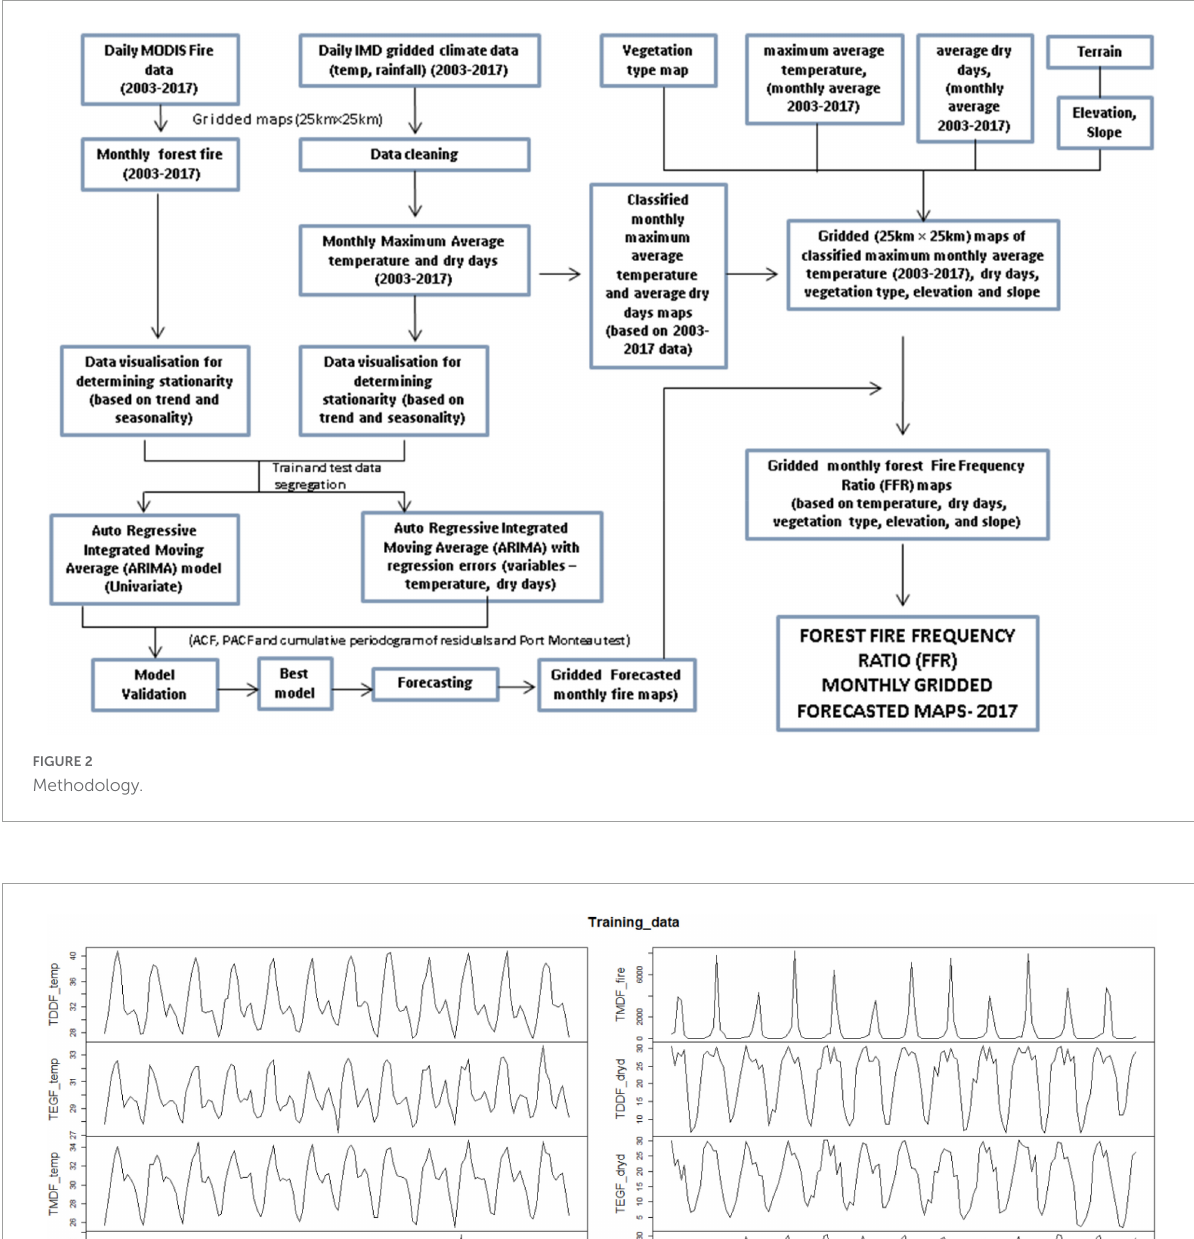
FIGURE3 Training datasets—TDDF_temp, TDDF_fire, and TDDF_dryd depicts monthly average maximum temperature, monthly fire counts, and number of dry days for Tropical Dry Deciduous Forests; TMDF_temp, TMDF_fire, and TMDF_dryd depicts monthly average maximum temperature, monthly fire counts and number of dry days for Tropical Moist Deciduous Forests; TEGF_temp, TEGF_fire, and TEGF_dryd depicts monthly average maximum temperature, monthly fire counts, and number of dry days for Tropical Evergreen